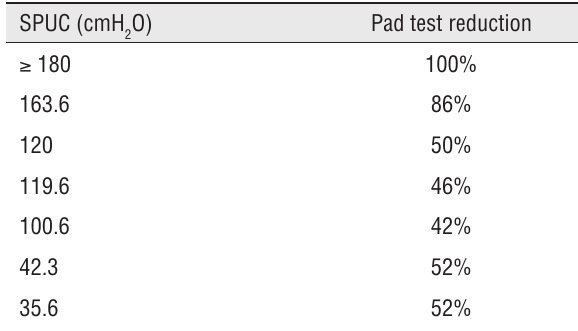
Table 2 - SPUC and percentile of